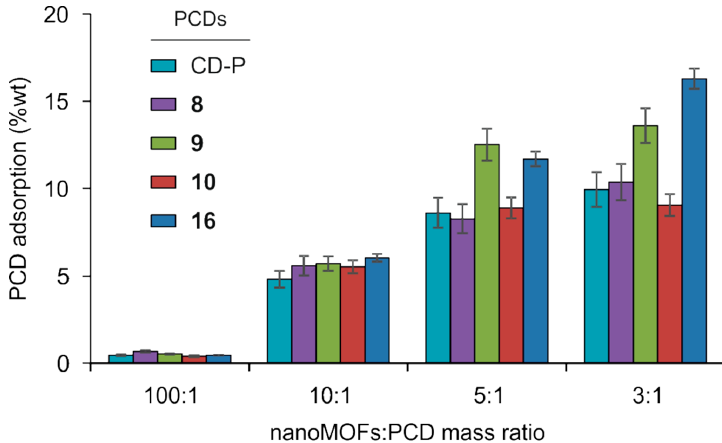
Figure 2. Phosphate β -CD derivatives (PCDs) grafting (wt%) versus nanoMOFs:PCDs mass ratio assayed.